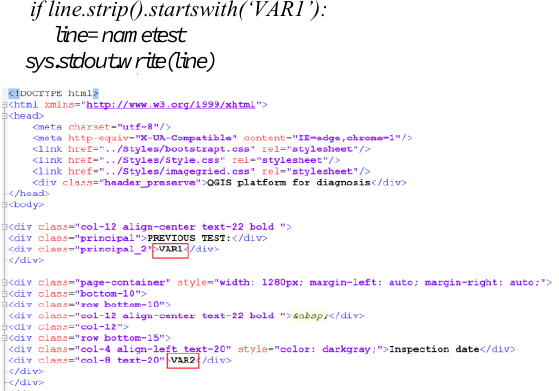
Figure 2. Appearance of the base file. The markers of the file are highlighted with a red rectangle.